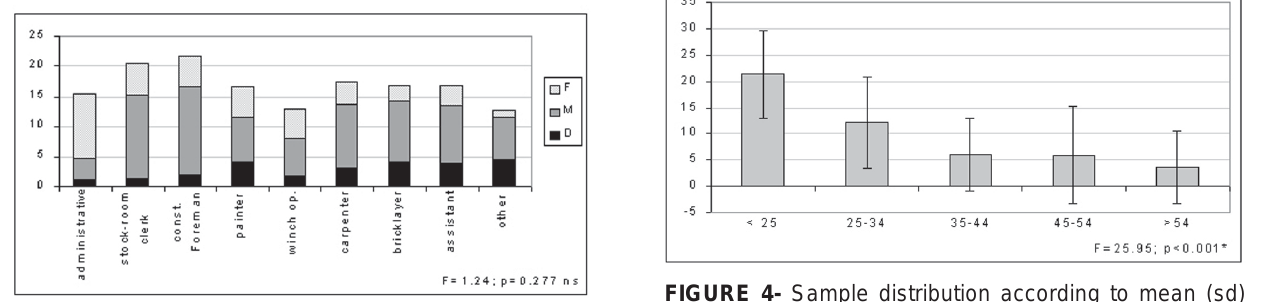
FIGURE 2- Prevalence of dental caries (DMFT) according to occupation. Bauru, Brazil, 2001